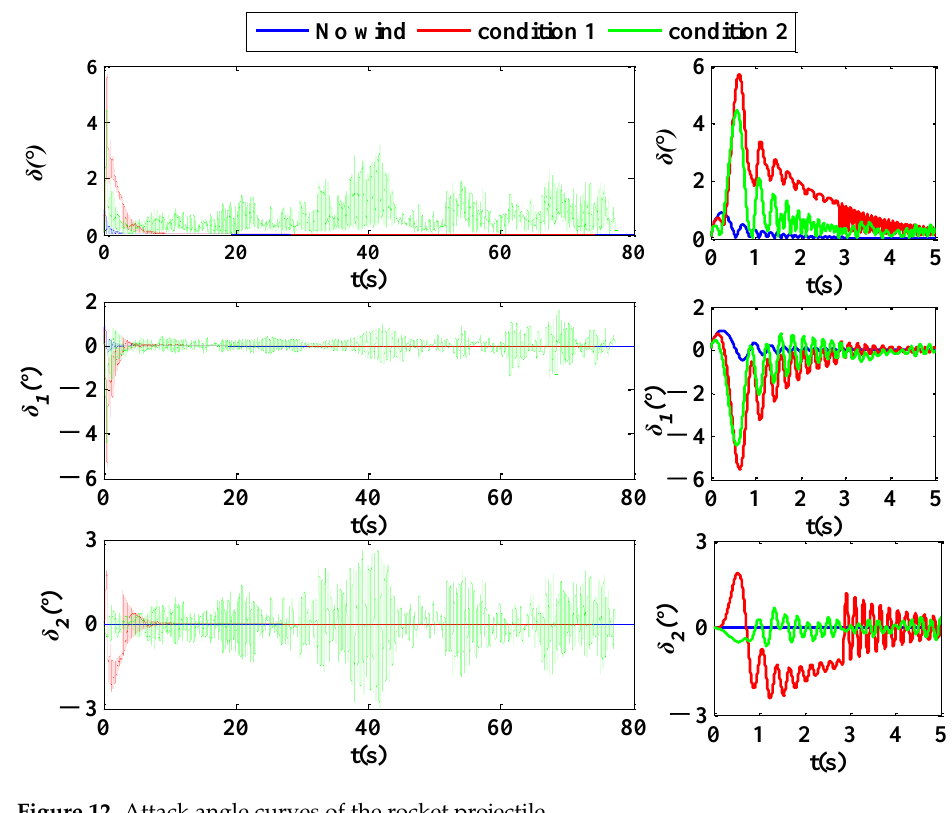
Figure 12. Attack angle curves of the rocket projectile.